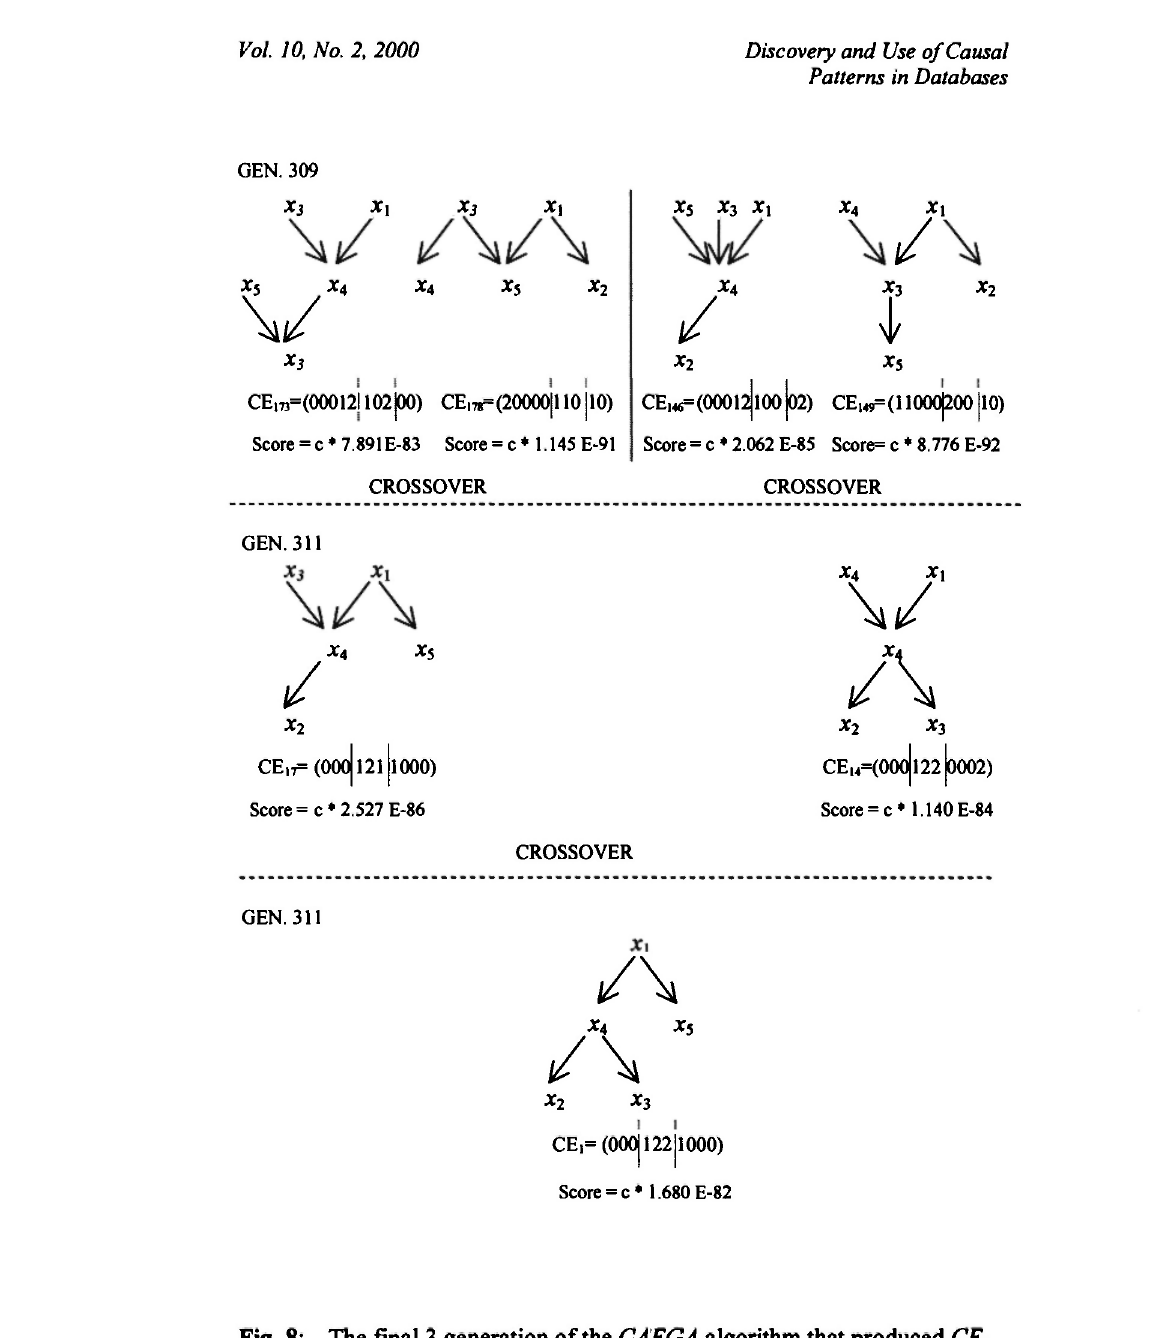
Fig. 8: The final 3 generation of the CAEGA algorithm that produced CE